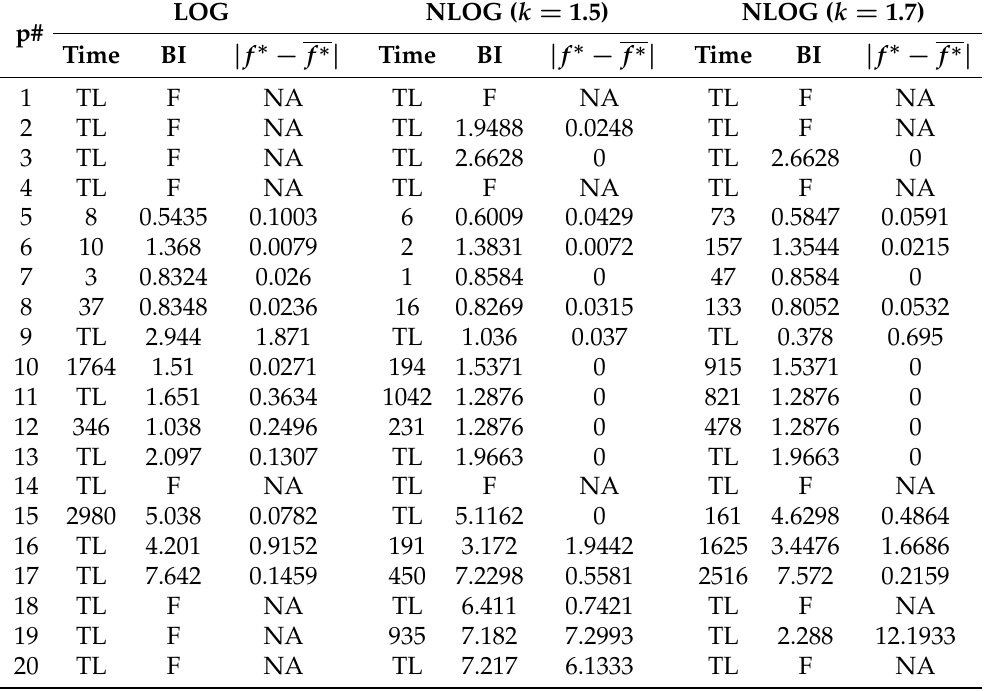
Table 5. Results of solving MILP problems produced with LOG and NLOG models using 11